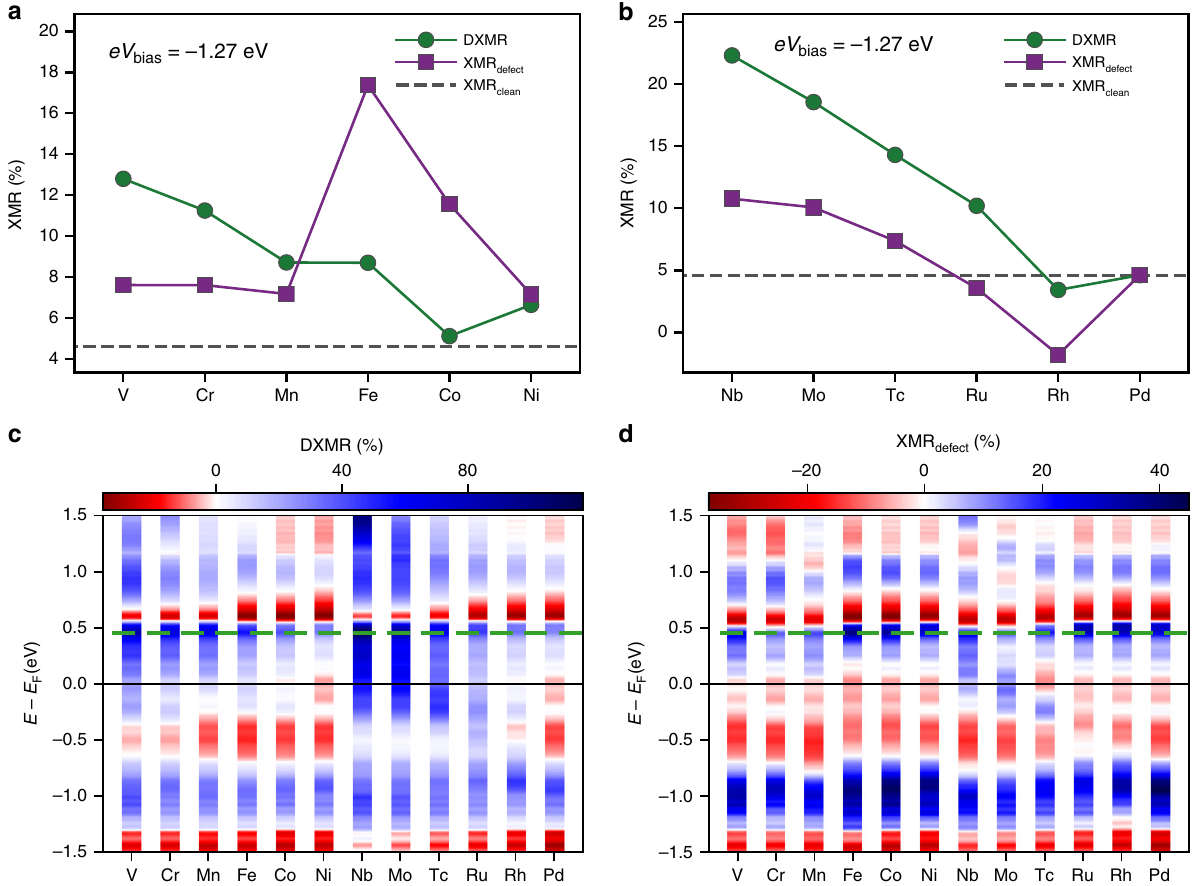
Fig. 4 Impact of the bias voltage on the defect-enabled XMR modes. Dependence of the DXMR signal (green circle) and XMR defect , (purple squares), on the atomic number of the a 3 d and b 4 d impurities at an injection energy eV bias = − 1.27 eV. The gray dashed line indicates the signal of the XMR clean . Bias voltage dependence of the c DXMR and d XMR defect signal for 3 d and 4 d defects. The color bars indicate the magnitude of the signal and the dashed green line shows the injection energy eV bias = 0.45eV studied in Figs. 2 and